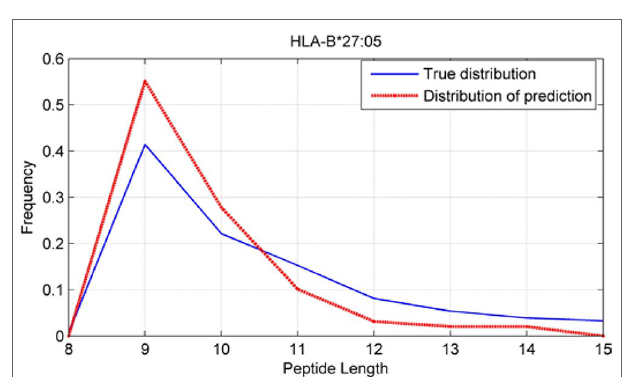
FIgURe 7 | The distribution ratio of F1 score.